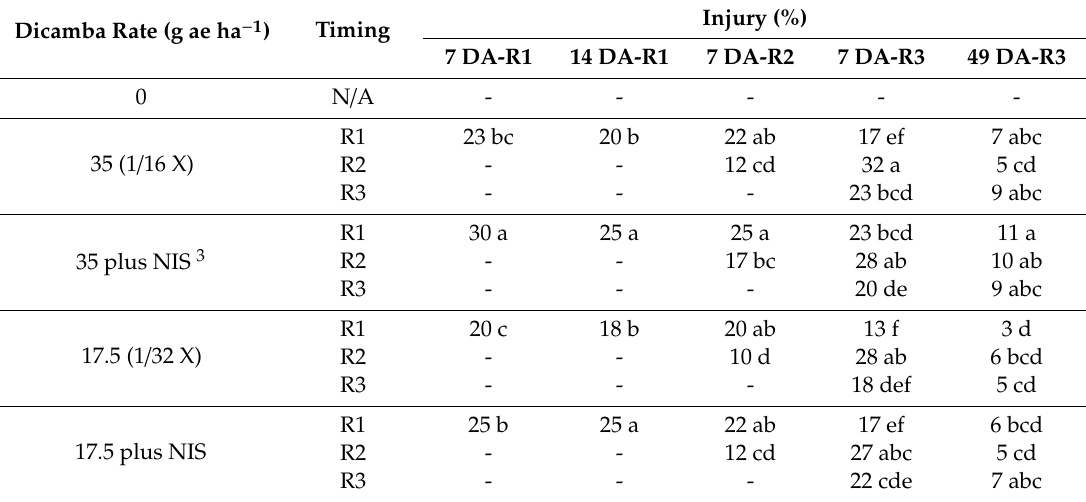
Table 2. Peanut injury following exposure to dicamba 7 and 14 DA-R1 1 , 7 DA-R2, and 7 and 49 DA-R3 at Stoneville, MS in 2018 2